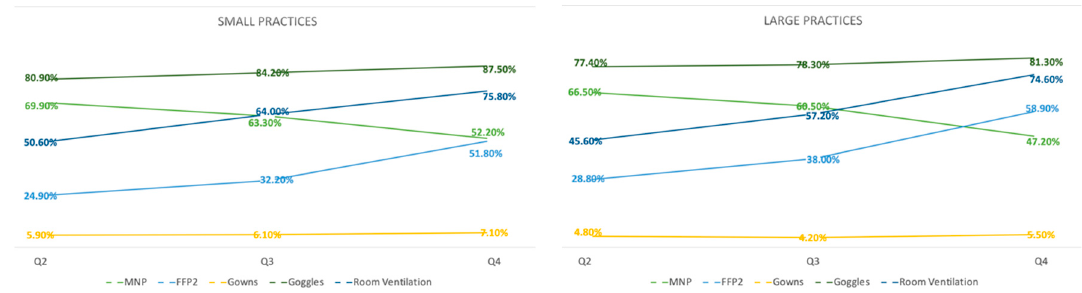
Figure 1. Personal protective equipment: usage from Q2 to Q4.